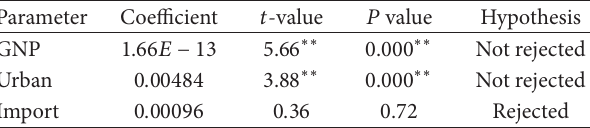
Table 4: Results of the Tobit regression